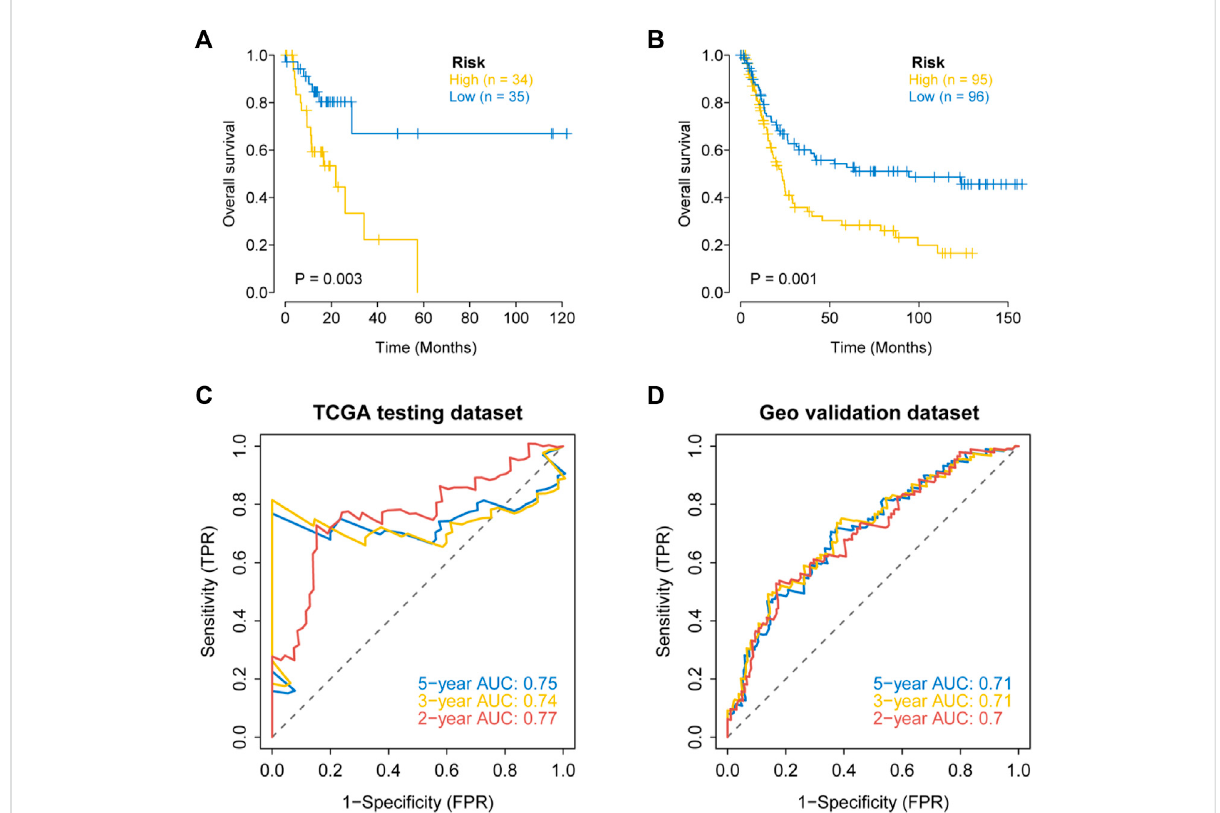
FIGURE 7 External validation of the apoptosis related genes signature in the TCGA testing dataset and the GEO dataset (GSE15459). (A) Kaplan – Meier curvesfortheOSofpatientsindifferentriskgroupsoftheTCGAtestingdataset. (B) Kaplan – MeiercurvesfortheOSofpatientsindifferentriskgroups of the GEO dataset (GSE15459). (C) Validation of ROC curves for apoptosis risk score in the TCGA testing dataset. (D) Validation of ROC curves for apoptosis risk score in the GEO dataset